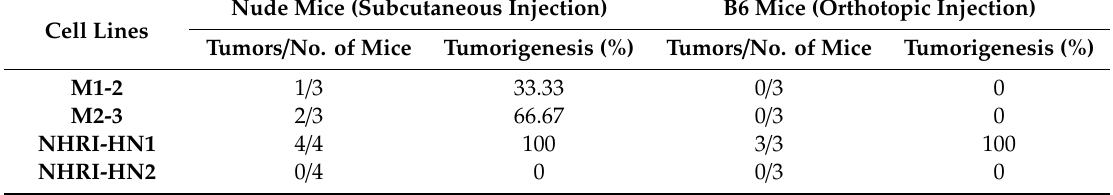
Table 1. Tumor formation in immunocompromised and immunocompetent mice injected with mouse oral squamous cell carcinoma (OSCC) cells.